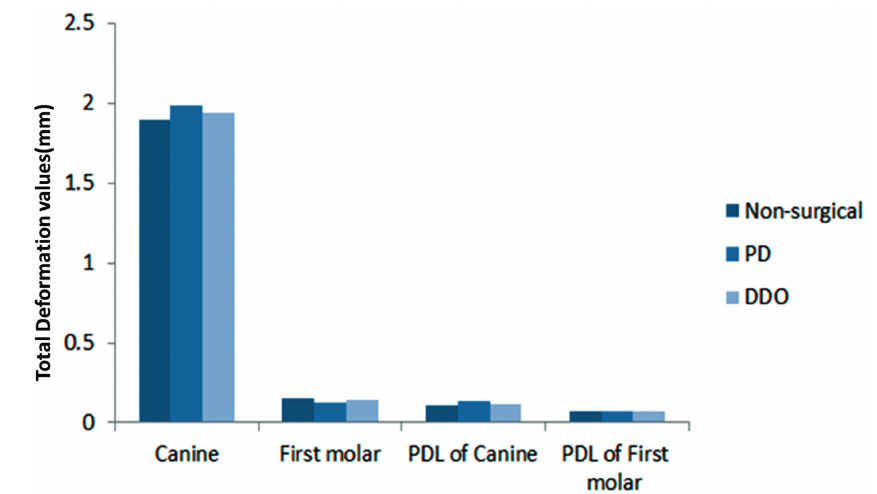
PD=periodontal distraction; PDL= periodontal ligament